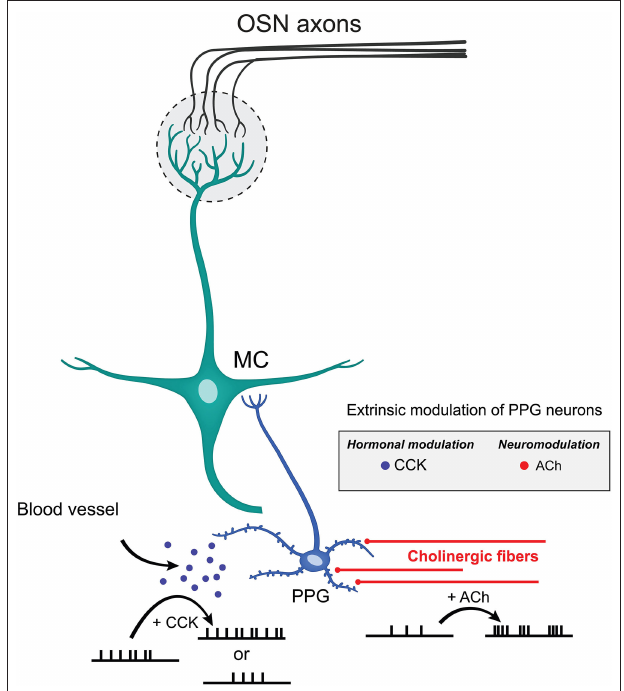
FIGURE 9 | Extrinsic modulation of PPG neurons. Schematic diagram summarizing the effects mediated by CCK and ACh on PPG neuronal firing. CCK release by the blood vessels may either reduce or enhance AP firing frequency while ACh released by cholinergic fibers increases action potential firing frequency while eliciting bursting behavior. Such diversity of modulation of PPG neurons within a PPG > MC > GC microcircuit could allow great dynamics of outputted information by MCs to the higher olfactory cortical